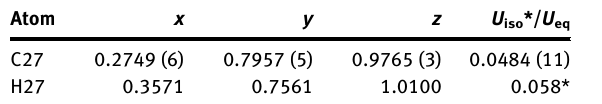
Table  : Fractional atomic coordinates and isotropic or equiva- lent isotropic displacement parameters (Å 